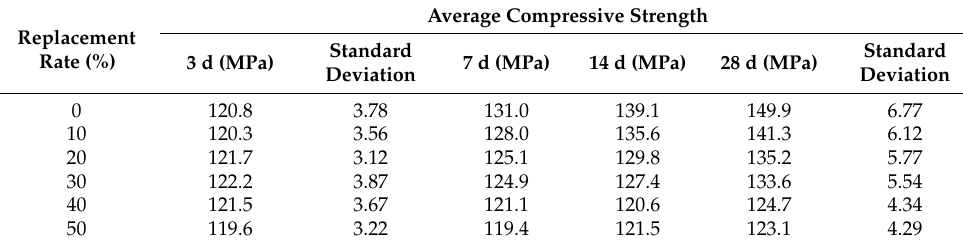
Figure 8. The compressive strength of recycled micropowder UHPC under different replacement rates. Table 4. The effects of the replacement ratio of regenerated micropowder on compressive strength. Replacement Rate